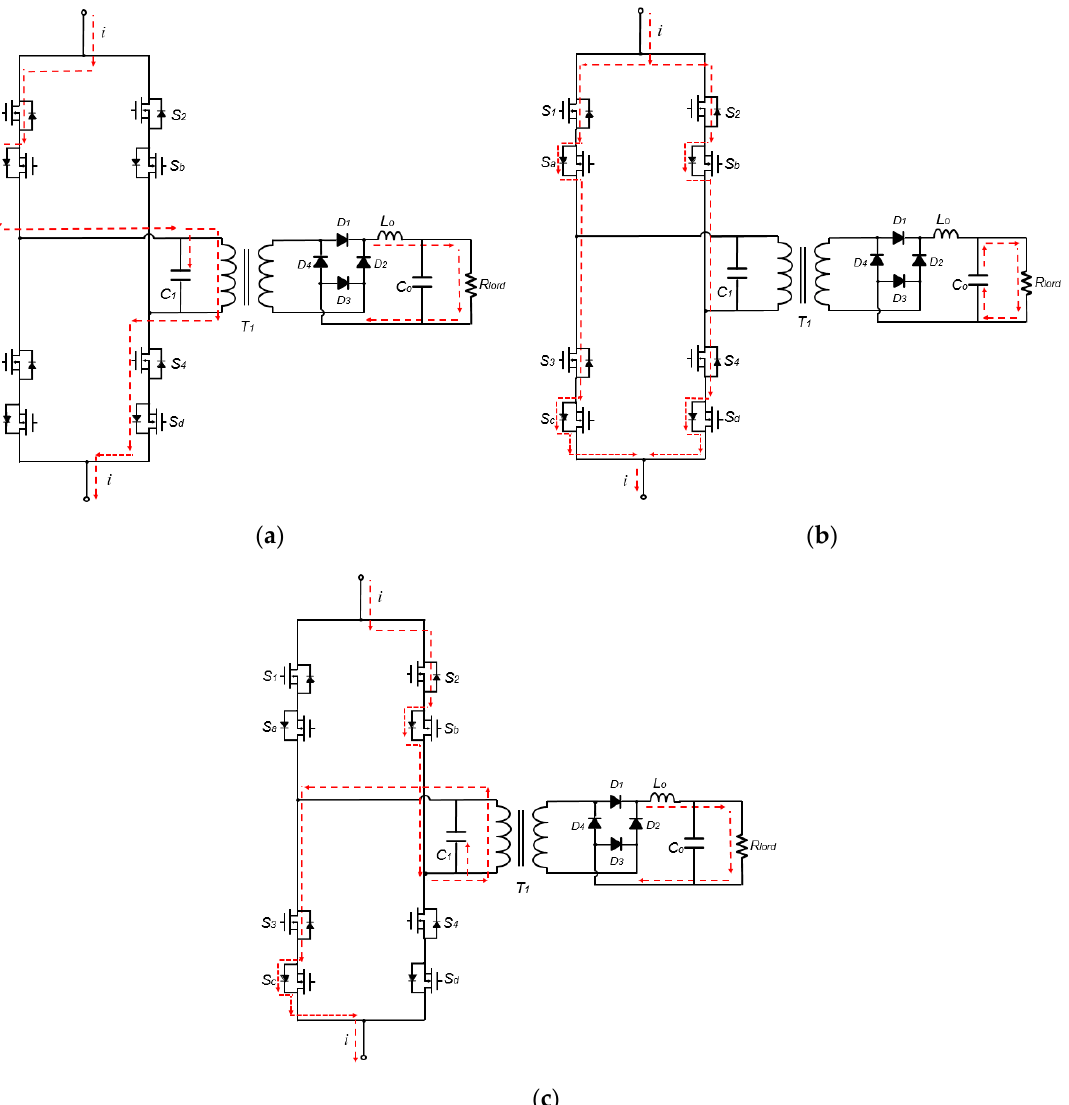
Figure 6. Three operating modes of the current-to-voltage converter. ( a ) Mode 1 (charging). ( b ) Mode 2 (no-charging). ( c ) Mode 3 (reverse charging).